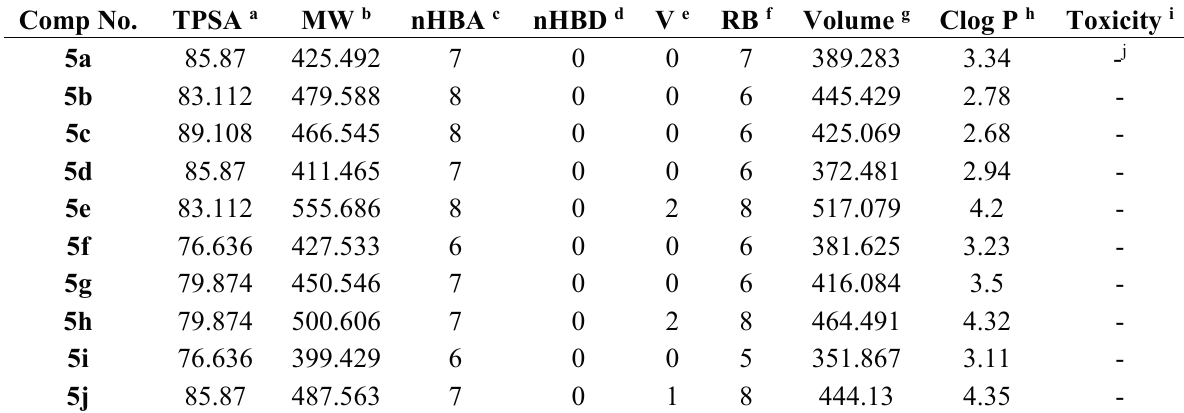
Table 3. Total polar surface area, calculated Lipinski’s rule of five, and toxicity risks for final